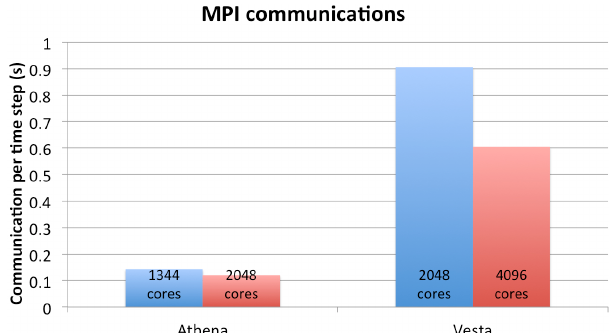
Figure 5. MPI communication time for two configurations for each architecture: with 1344 and 2048 processes on ATHENA and with 2048 and 4096 processes on VESTA.